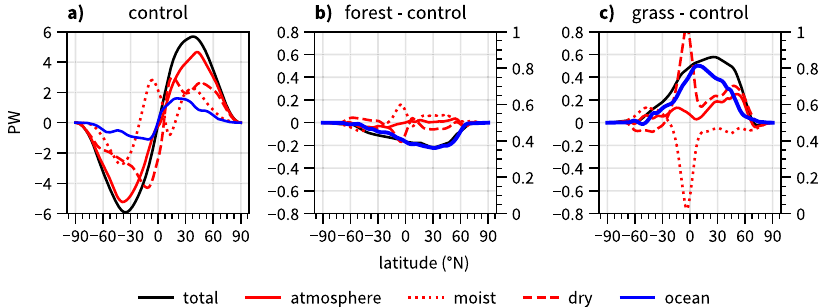
Fig. 2 | Changes of the annual mean meridional heat transport in atmosphere andocean. Shownare a meridionalheattransportincontrol, b itschangesin forest with respectto control , and c its changes in grass with respect to control . The total